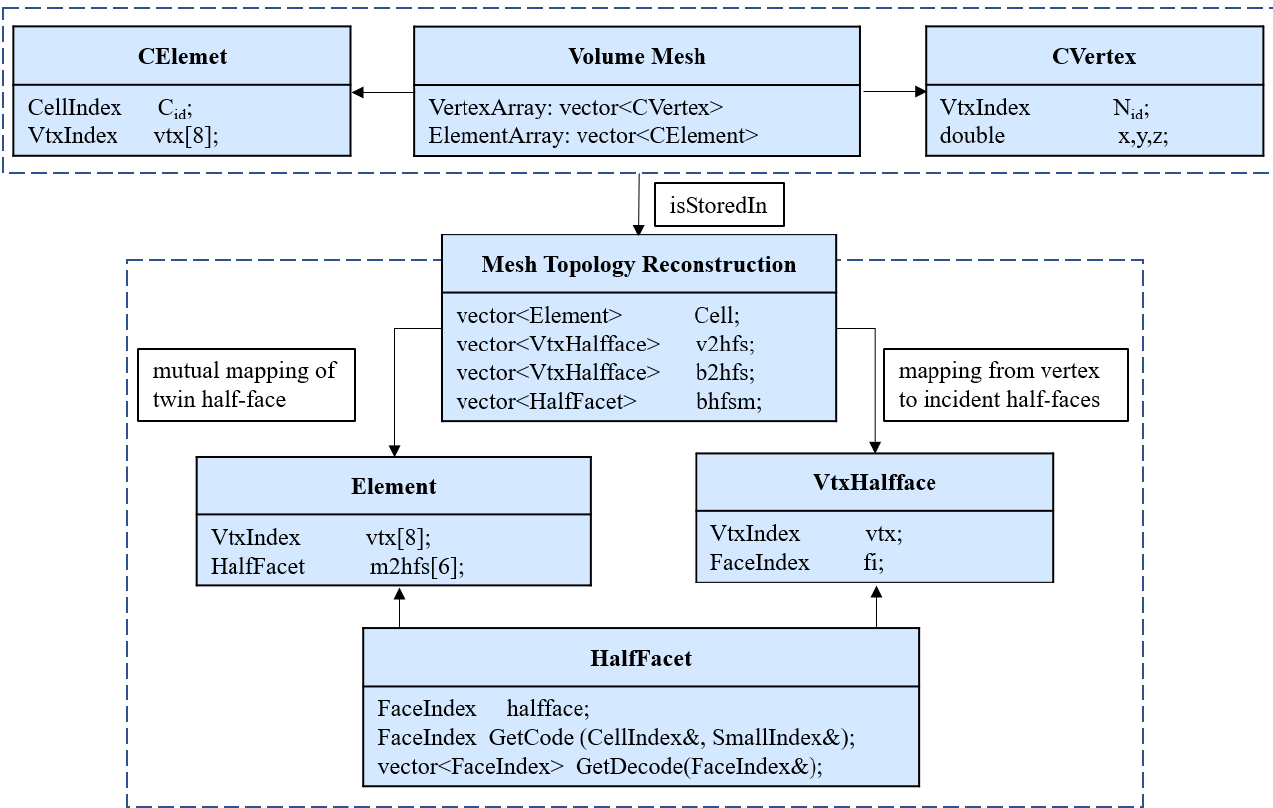
Figure 5. Class diagram of the CAHF volume mesh model. Let CellIndex , FaceIndex and VtxIndex denote the ID of element, half-face and vertex, respectively. SmallIndex is the local ID of the face. The type of these variables is unsigned int.